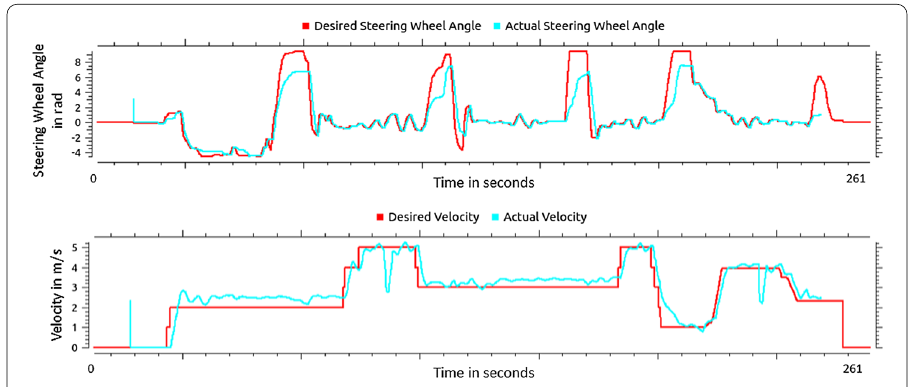
Fig. 5 Tracking performance of the steering wheel angle and the